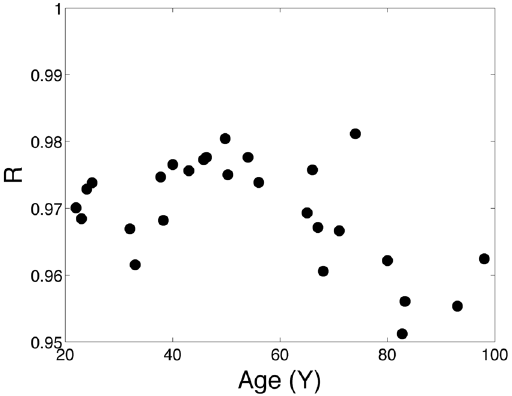
Figure 1. Plot of Pearson’s correlation coefficient R between MZ couples whole-genome expression profiles as a function of